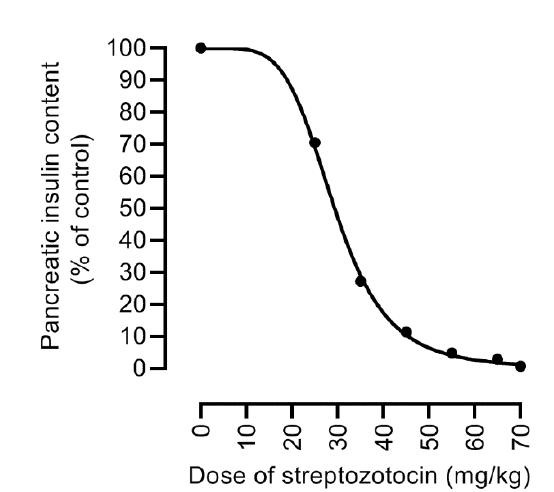
Figure 2: Relation between streptozotocin dose and pancreatic insulin content, recorded from 24 h to 35 days after the streptozotocin injection in rats. Data were obtained from (Junod et al., 1967, 1969; Stauffacher et al., 1970; Robbins et al., 1980; Rodrigues et al., 1997). In the case that data was presented in a graph, values were ex- tracted using Photoshop, as previously reported (Gheibi et al.,